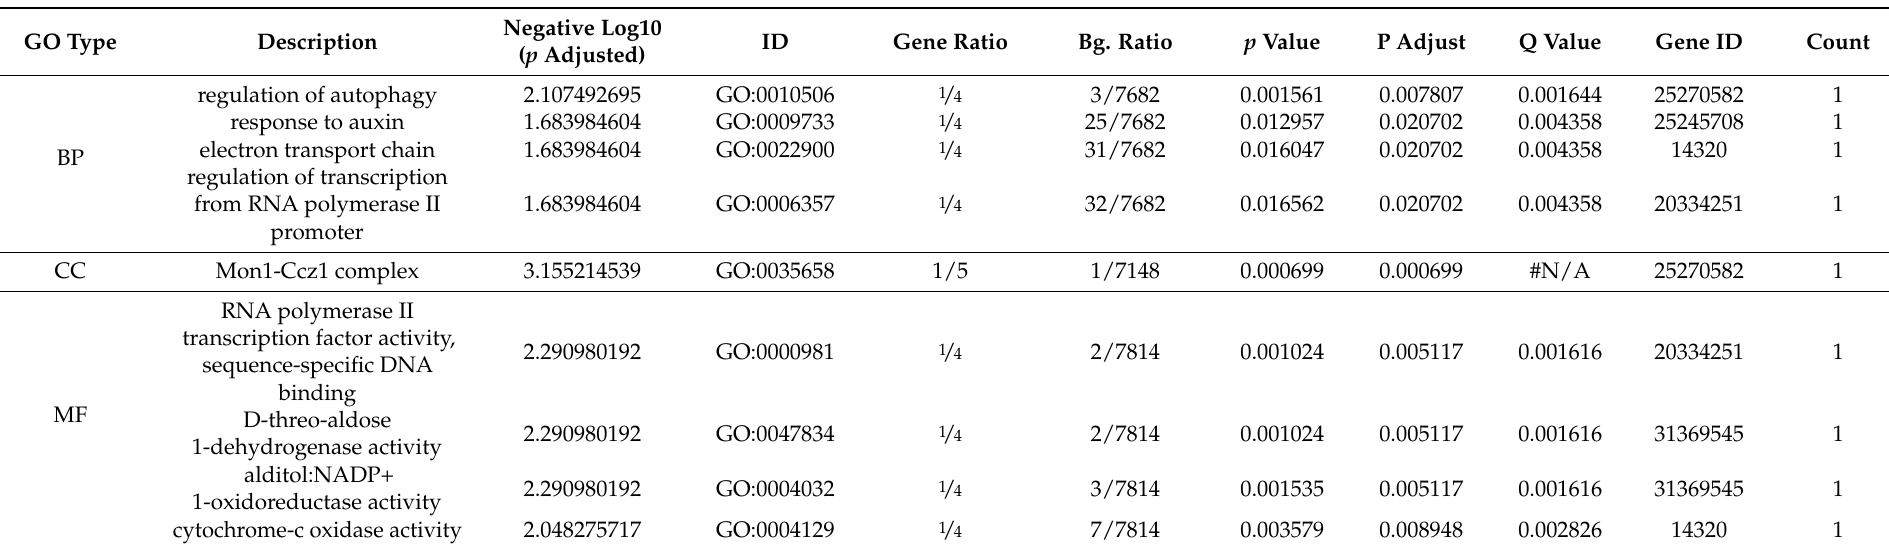
Table 3. SDGs ontology created using the reference annotation of IWGSC wheat genomes. For this purpose, drought protein sequences were annotated using